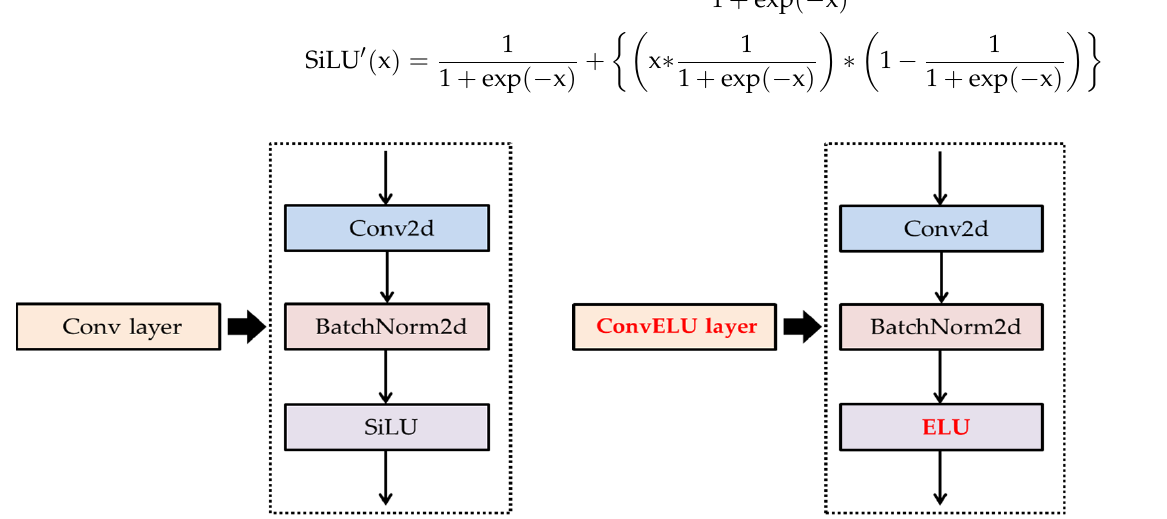
Figure 3. Comparison of Conv and Conv_Ours layer ( Left figure is the existing layer, Right figure is the way we suggest